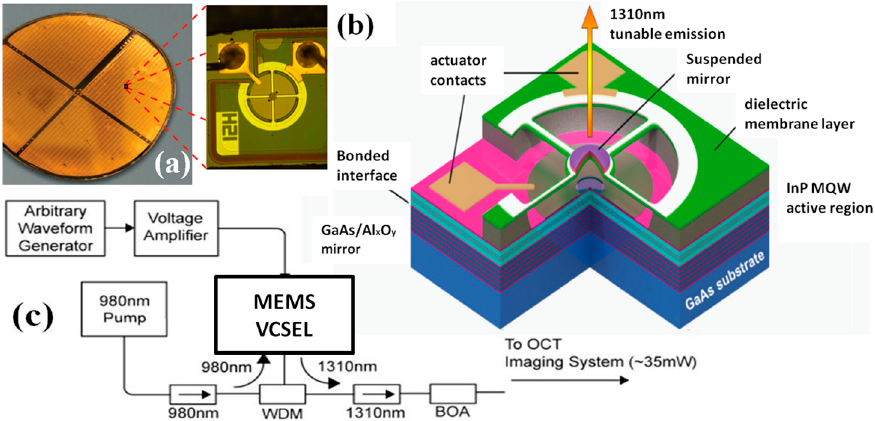
Figure 4. MEMS tunable VCSEL laser source for ultrahigh speed 60 kHz–1 MHz axial scan rate and long range centimeter class OCT imaging: ( a ) wafer of VCSELs with zoom showing wire bonded MEMS actuator; ( b ) schematic drawing of the MEMS tunable VCSEL structure; and ( c ) schematic drawing of the OCT laser source based on the MEMS VCSEL module ( Reproduced with permission from SPIE [38]).